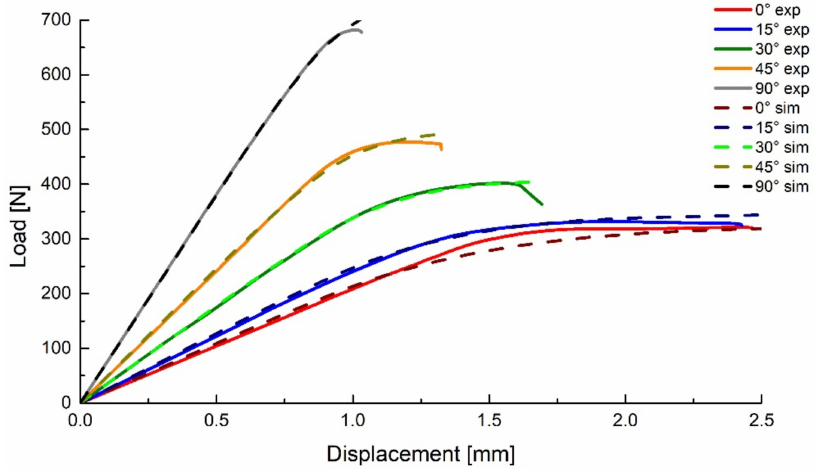
Figure 16. Experimental and numerical results for the Arcan tests.